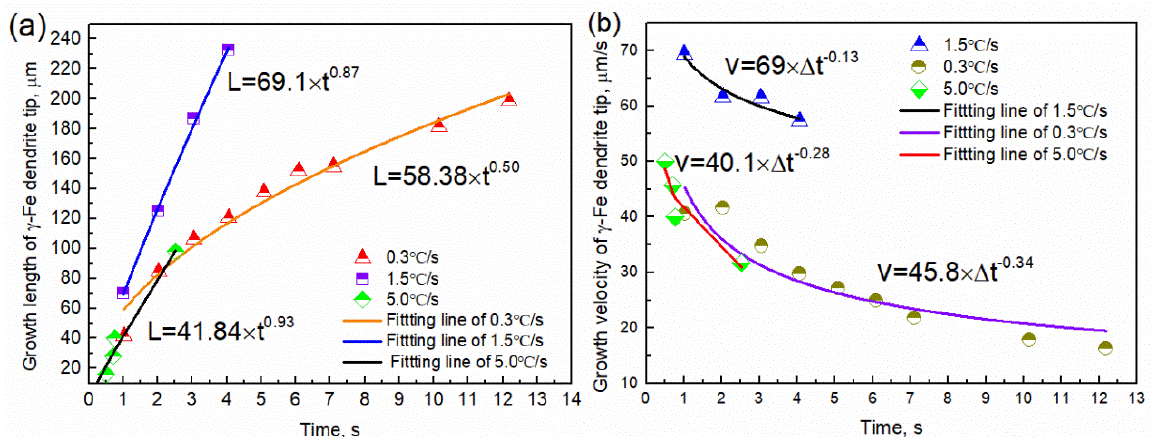
Figure 7. Image analysis results of the γ − Fe dendrite growing at 1286.5 − 1282.8 ◦ C, 1273.1 − 1267.0 ◦ C, and 1224.6 − 1218.3 ◦ corresponding to the cooling rates of 0.3 ◦ C/s, 1.5 ◦ C/s and 5.0 ◦ C/s: ( a ) the growth length of the γ − Fe dendrite with time; ( b ) the growth rate of the γ − Fe dendrite with time.